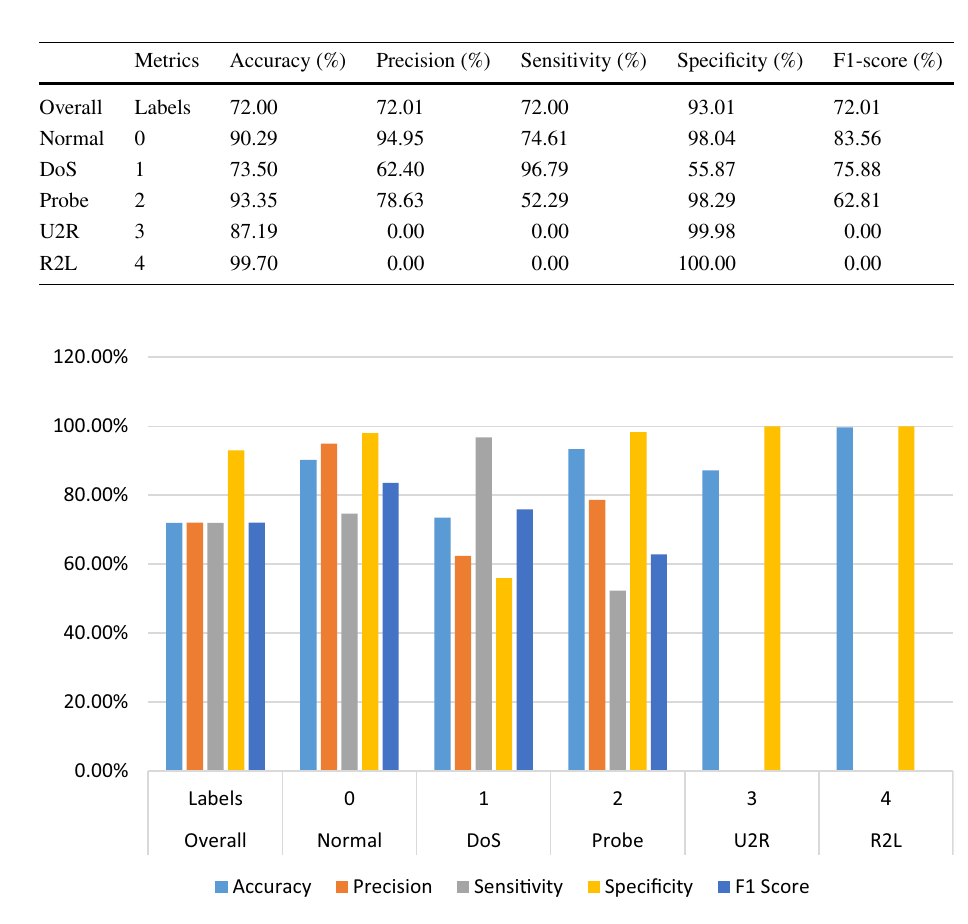
Table 12 Confusion matrix after feature